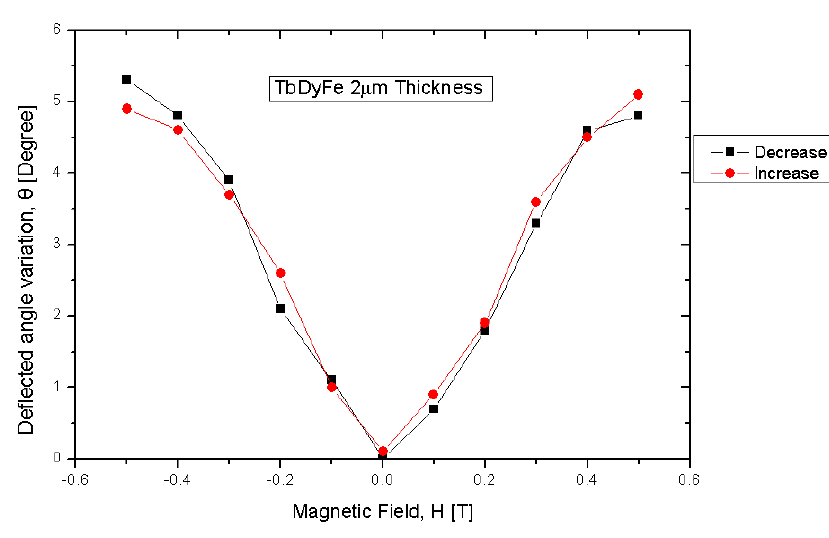
Figure 10. Magnetostriction and magneto-optical characteristics: Deflected light angle changes under magnetic